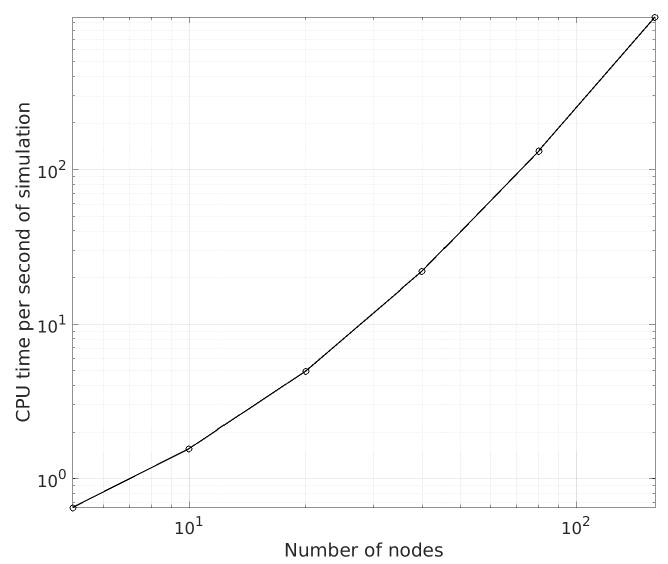
Figure 9. Dependence of the computational cost with the number of nodes for Zhu experiment simulation. The slope on the logarithmic scale was found to be 3.267.